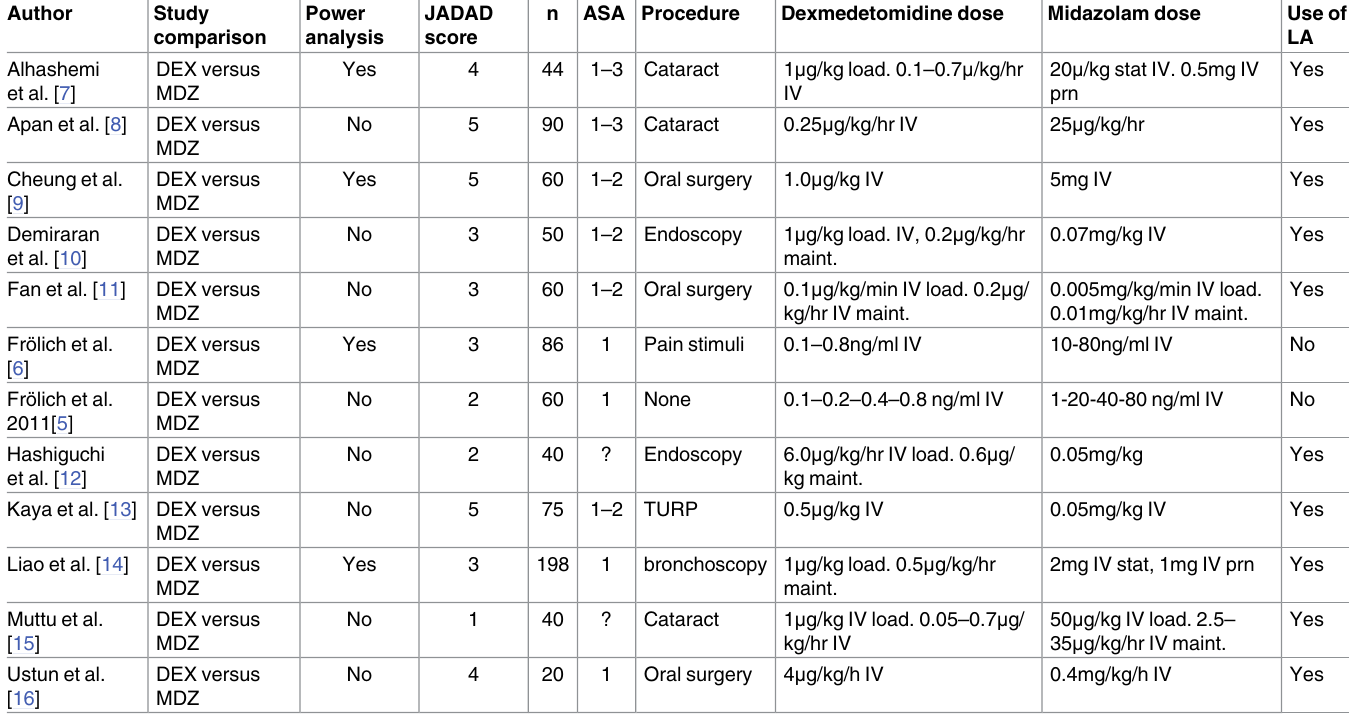
LA: Local Anesthetic; DEX: dexmedetomidine; MDZ:mMidazolam; IV: intravenous; IN: intranasal; prn: pro re nata (as needed); stat: statim (once); TURP: Transurethral Resection of the Prostate; AFOI: Awake Fibreoptic Intubation.; load.: loading dose; maint.: maintenance dose.